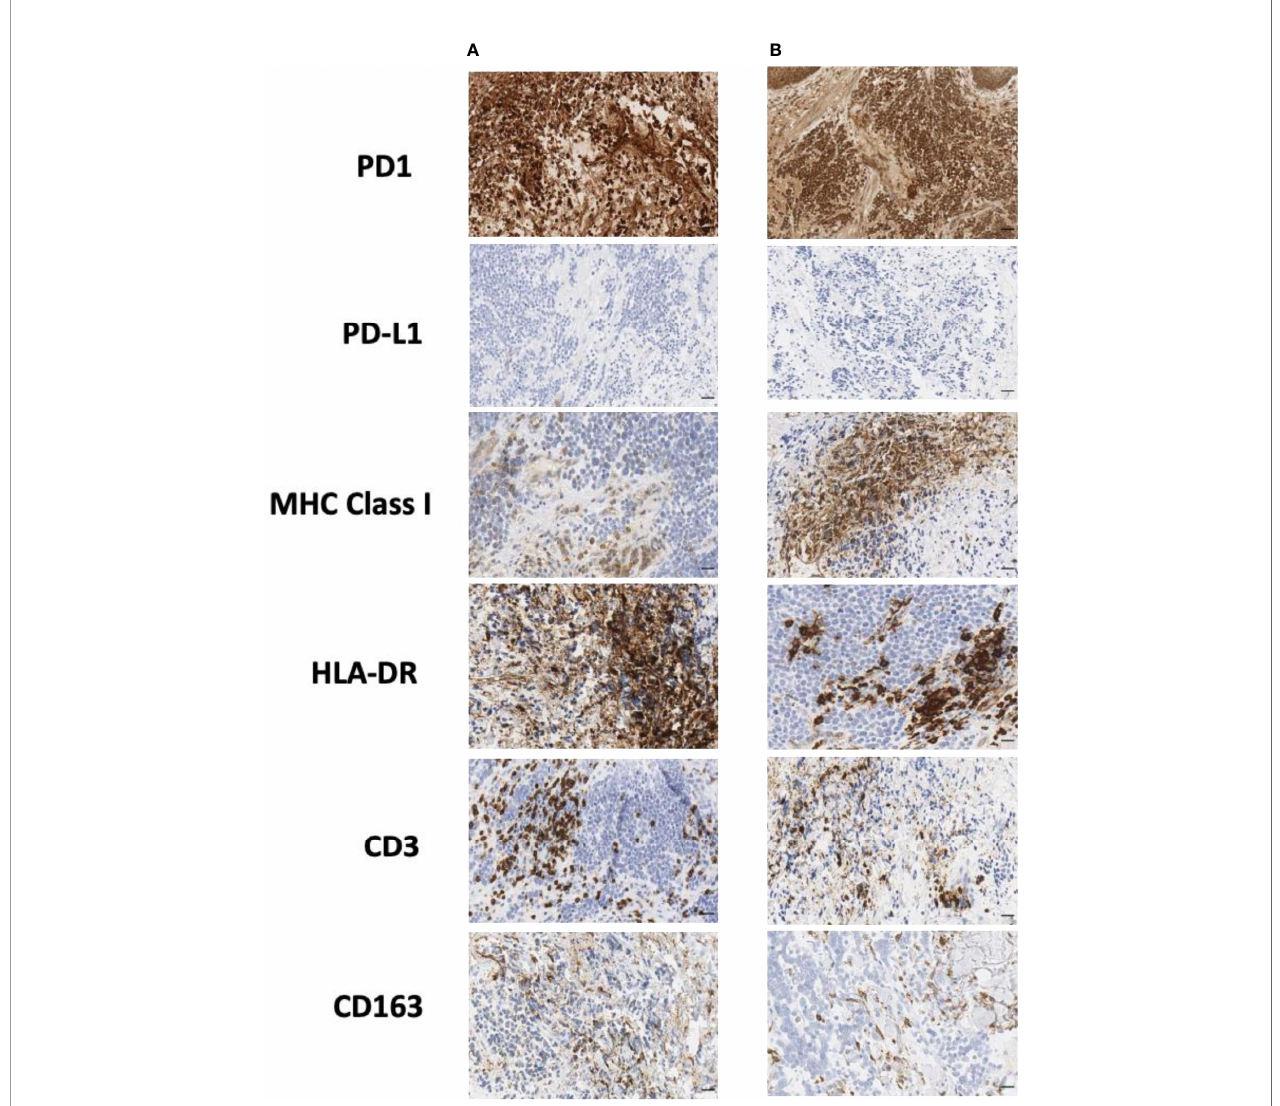
FIGURE 4 | Immunohistochemical staining of biopsy samples taken (A) during surgery and (B) after ECT. CD, cluster of differentiation; ECT, electrochemotherapy; HLA, human lymphocyte antigen; MHC, major histocompatibility complex; PD-1, programmed cell death protein-1; PD-L1, programmed cell death-ligand 1. Scale bar: 50